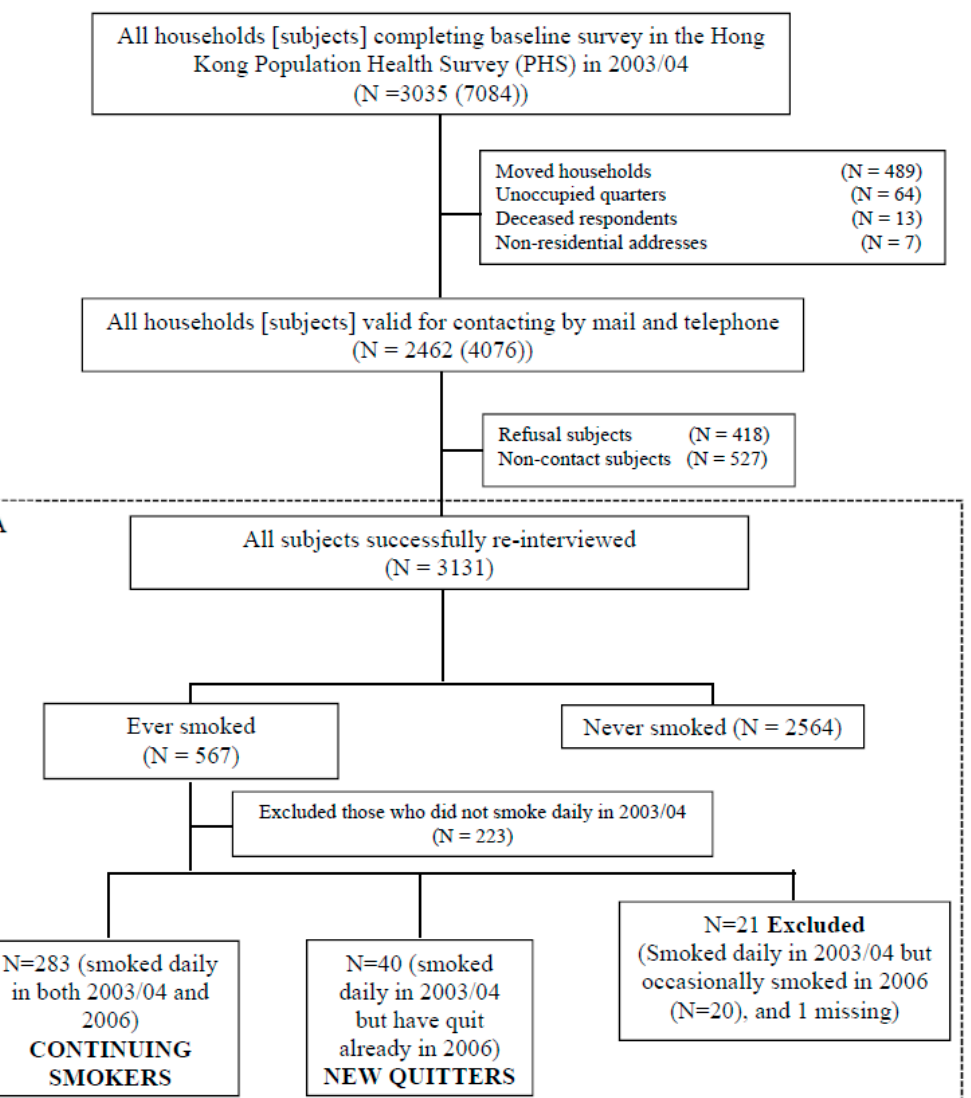
Figure 1. Summary of subjects included at baseline survey (2003/04), and subjects who were continuing smokers and new quitters ( A ) at follow ‐ up.